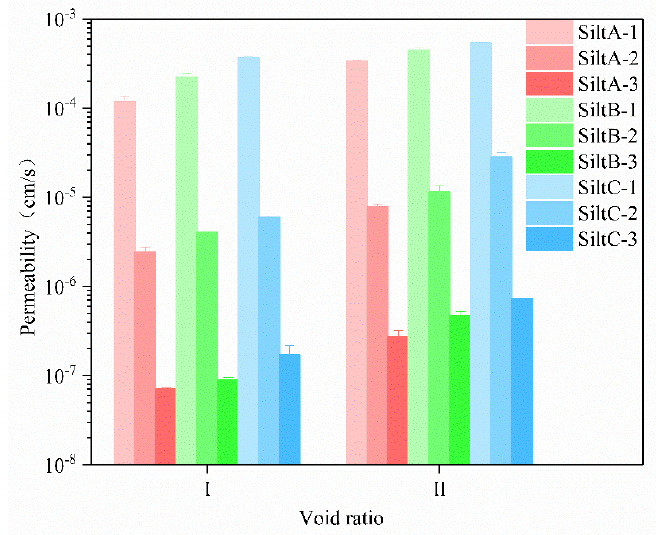
Figure 14. Influence of different pore ratio on permeability coefficient.